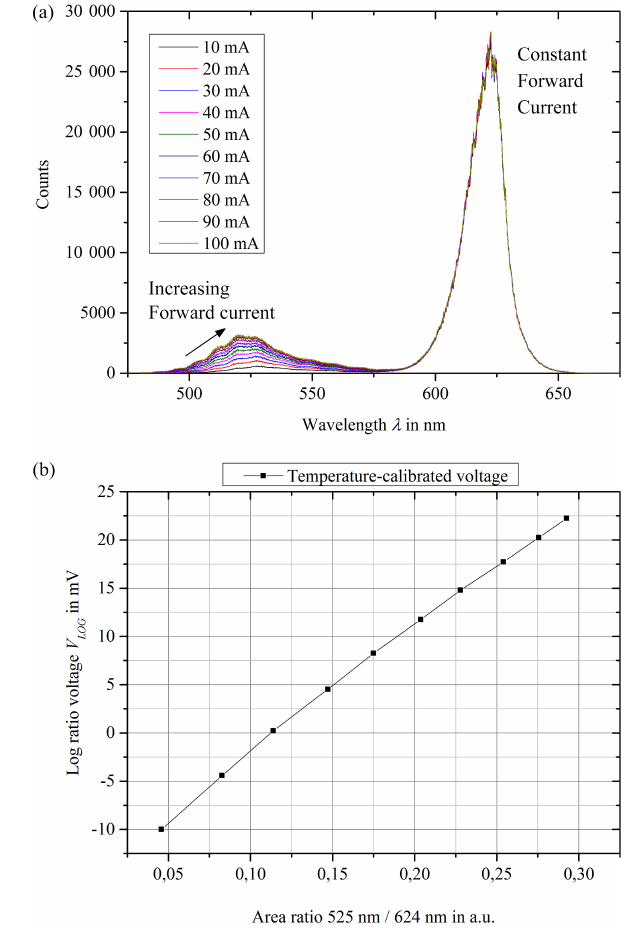
Figure 4. (a) Ratiometric spectra consisting of a baseline at 624nm and a varying peak intensity at 525nm. (b) Calculated ratios of the area under the respective emission curves to the measured log ratio voltage of the WSPD readout